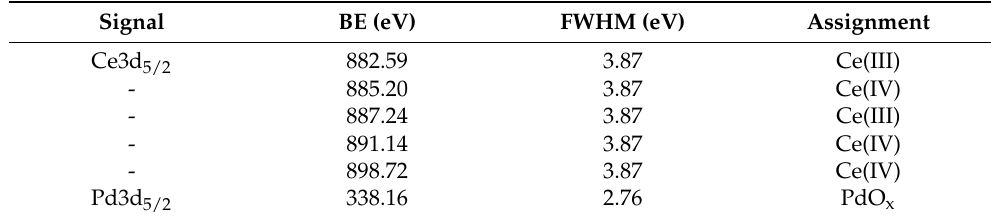
Figure 4. X-ray photoelectron spectroscopy (XPS) spectra of ( a ) Pd 3d region, ( b ) Ce 3d region for PdO X /CeO 2 -NR. Table 2. Binding energy (BE) and full width at half maximum (FWHM) values and proposed assignments for the PdO x /CeO 2 -NR catalyst.